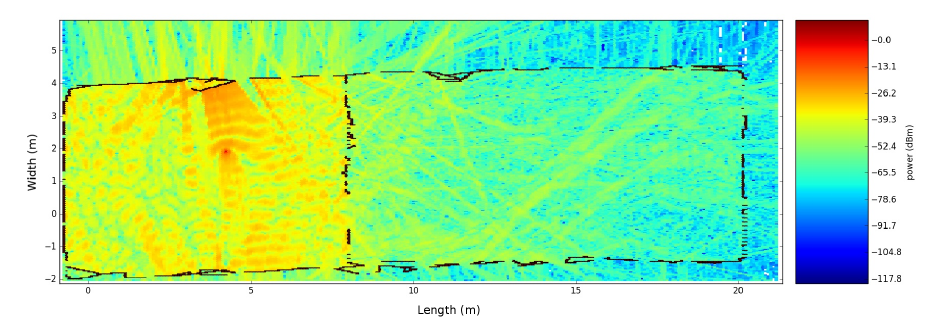
Figure 18. Received Signal Strength (RSS) heatmap of the transmitter that is located at position 2.